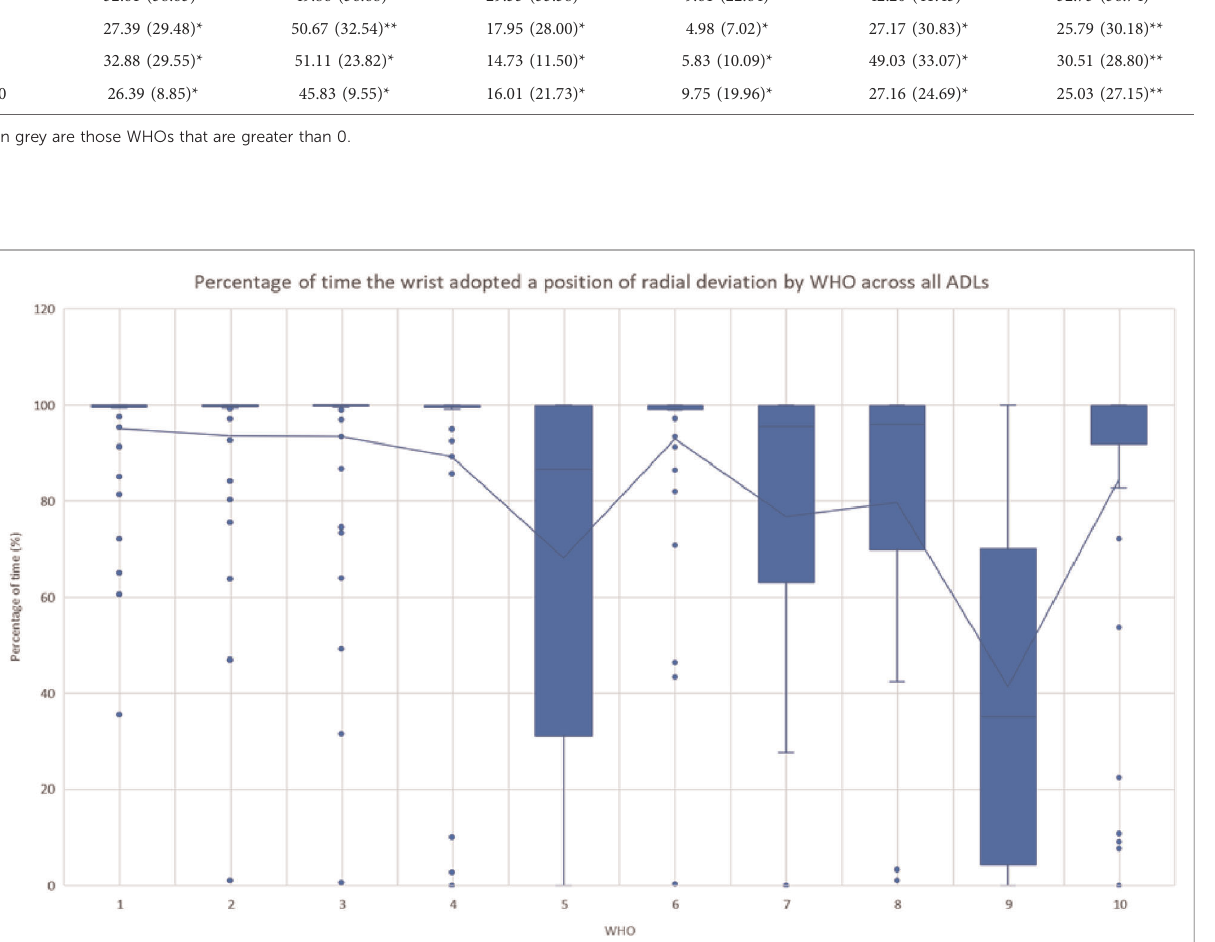
FIGURE 4 Percentage of time when the wrist was over 15° of extension regardless of the ADL by WHOs. The outliers are shown with the circles, with mean values shown by the line. Statistical signi fi cance is given in Table 5